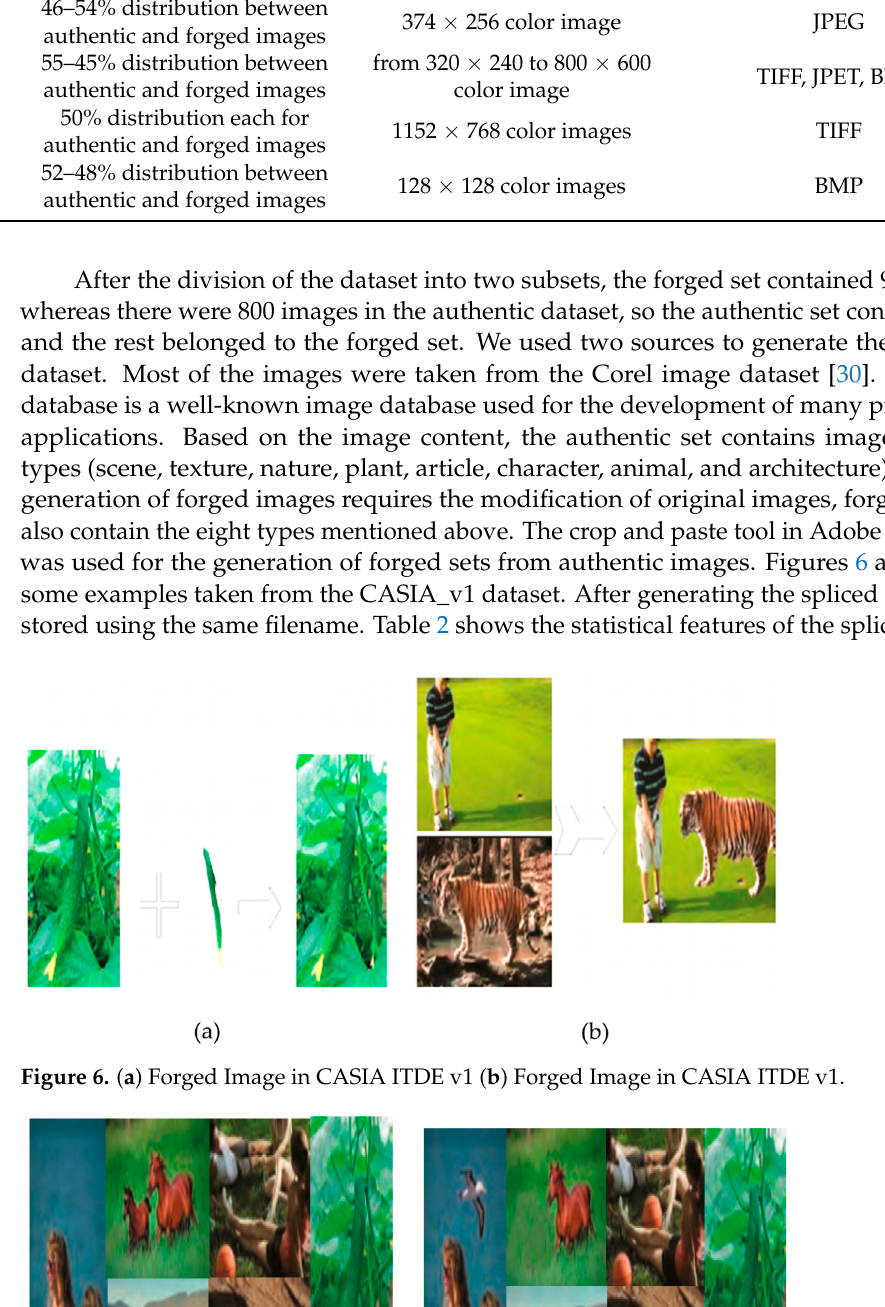
Table 1. Difference between CASIA_v1 and CASIA_v2 datasets.